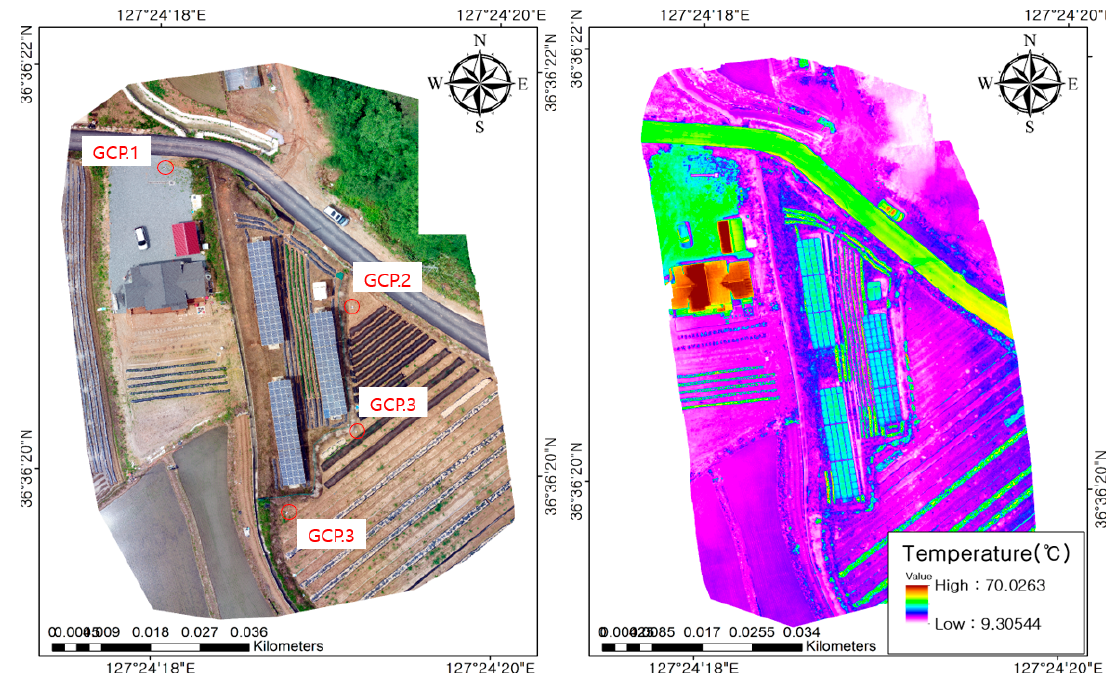
Figure 5. Orthographic images of RGB and thermal infrared images.